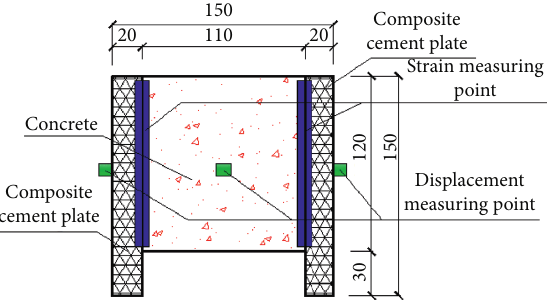
Figure 1: A schematic of the composite sample showing the structure and